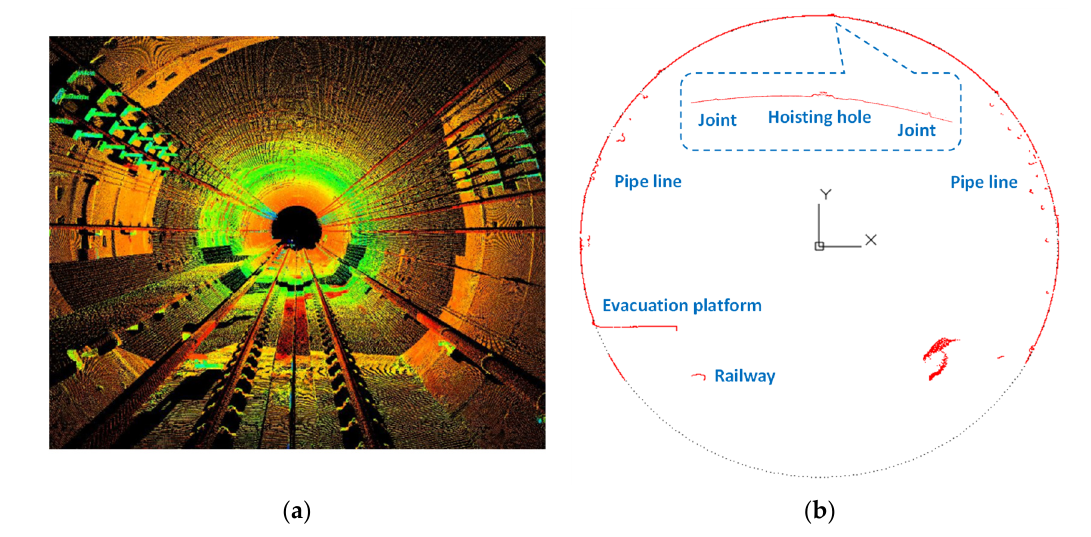
Figure 11. ( a ) The layout of the metro tunnel and ( b ) the corresponding laser scanning results.